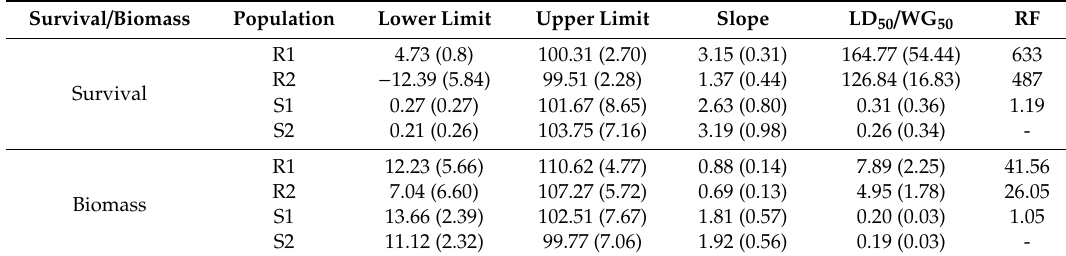
Values in parentheses are standard